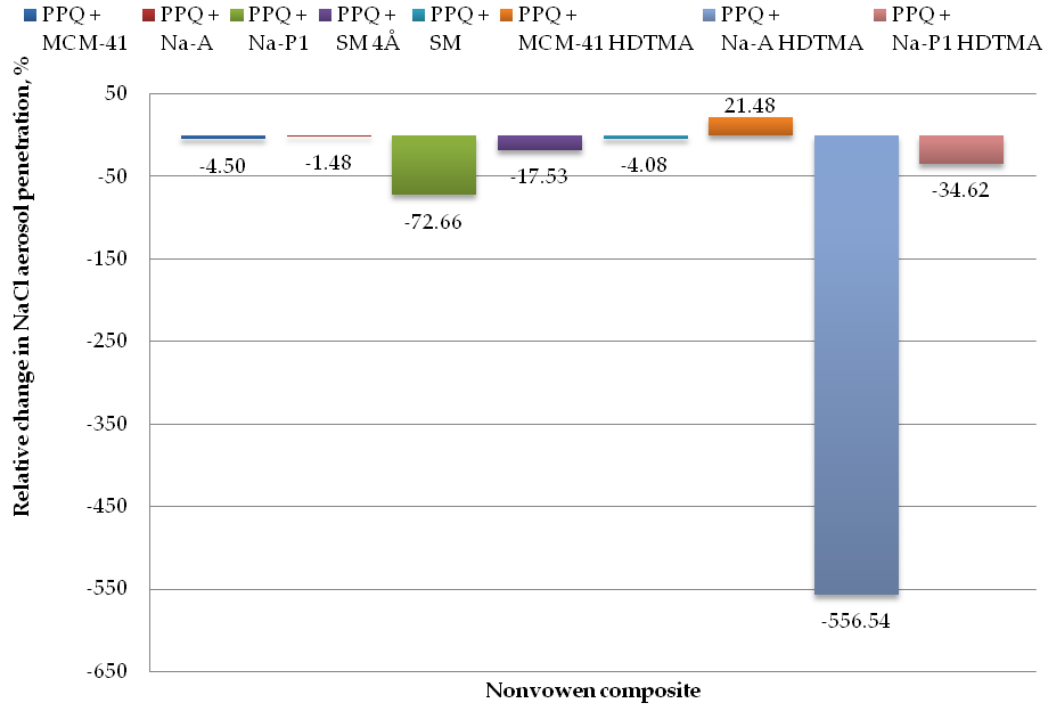
Figure 10. Relative change in NaCl aerosol penetration for nonwoven zeolite and silica composite.